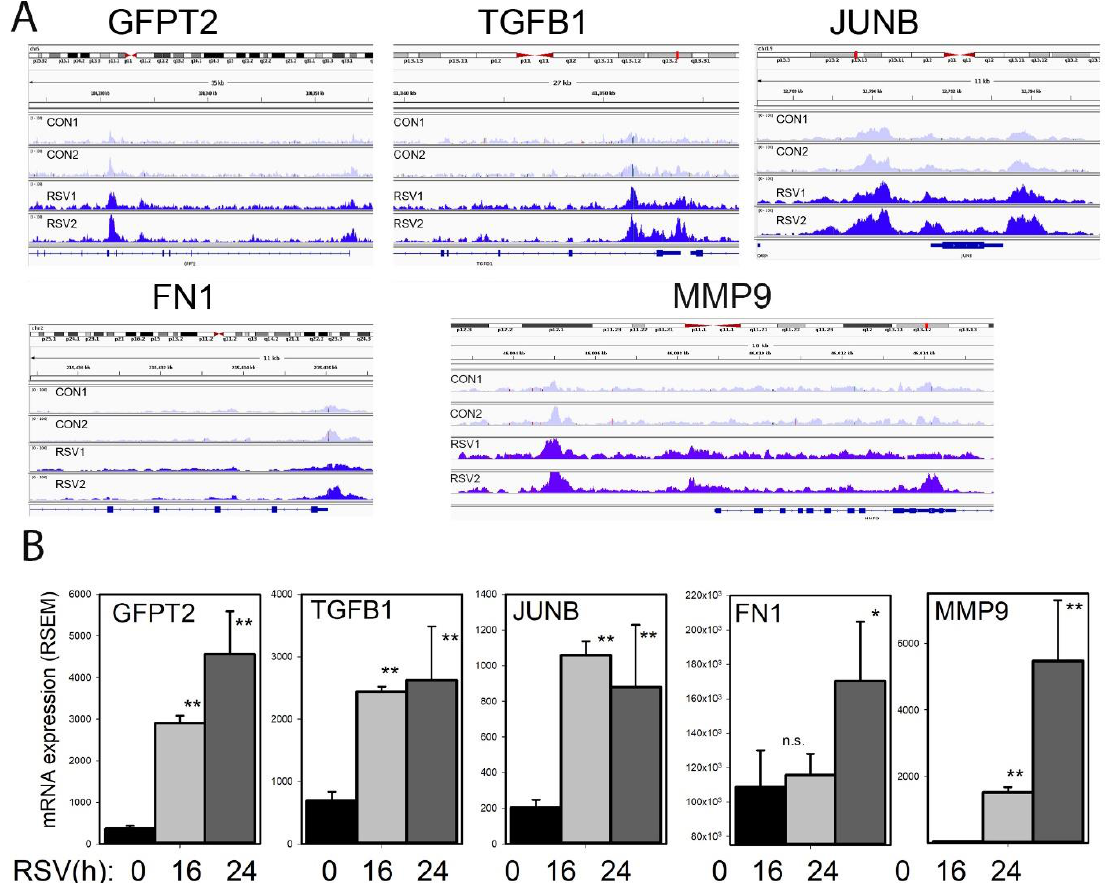
Figure 11. Inducible chromatin changes in the TGF β growth factor-ECM pathway. ( A ) Integrated genomic viewer (IGV) of ATAC-Seq cleavage fragments mapped to the GFPT2, TGFB1, JUNB, and FN1 genes in control and RSV-infected state. Note the increased transposase digestion of promoter elements after RSV infection. ( B ) mRNA changes of each gene. Shown is mean ± SD ( n = 4 independent RNA-seq reads quantified by RSEM). *, p < 0.05, **, p < 0.01 post hoc Tukey’s test.